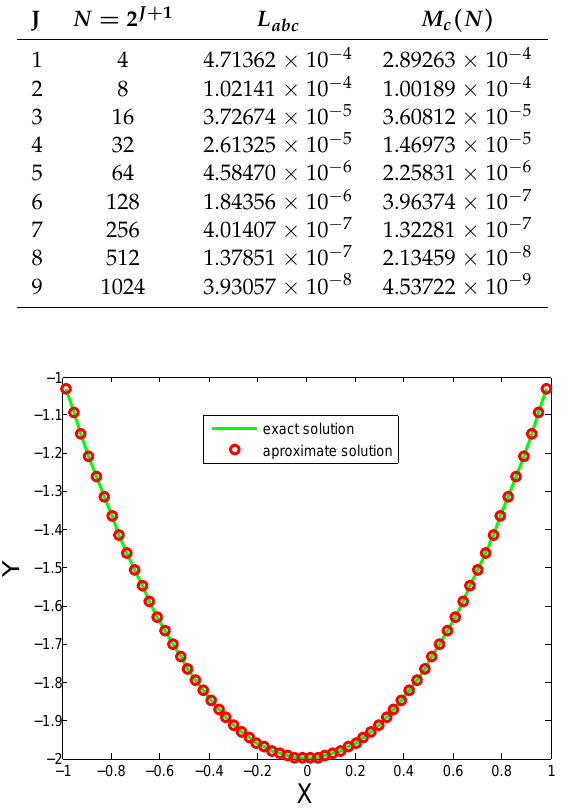
Figure 3. Comparison of both solutions for N = 32 for Test Problem